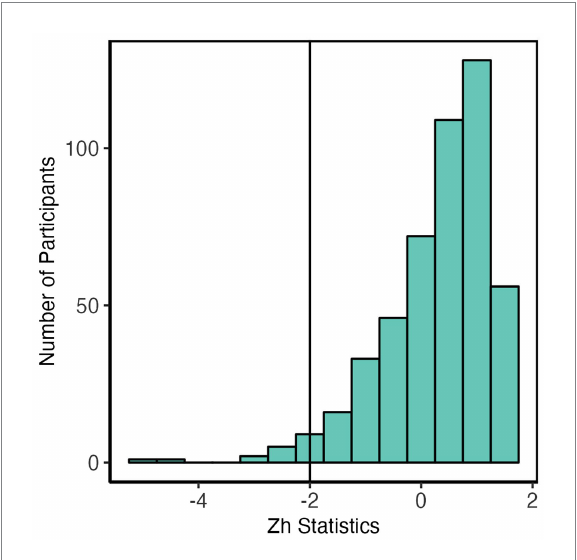
FIGURE 5 Person fit: Distribution of the Z h statistic of the 2PL model. Z h is larger than-2 for most participants indicating a good fit for the IRT model.